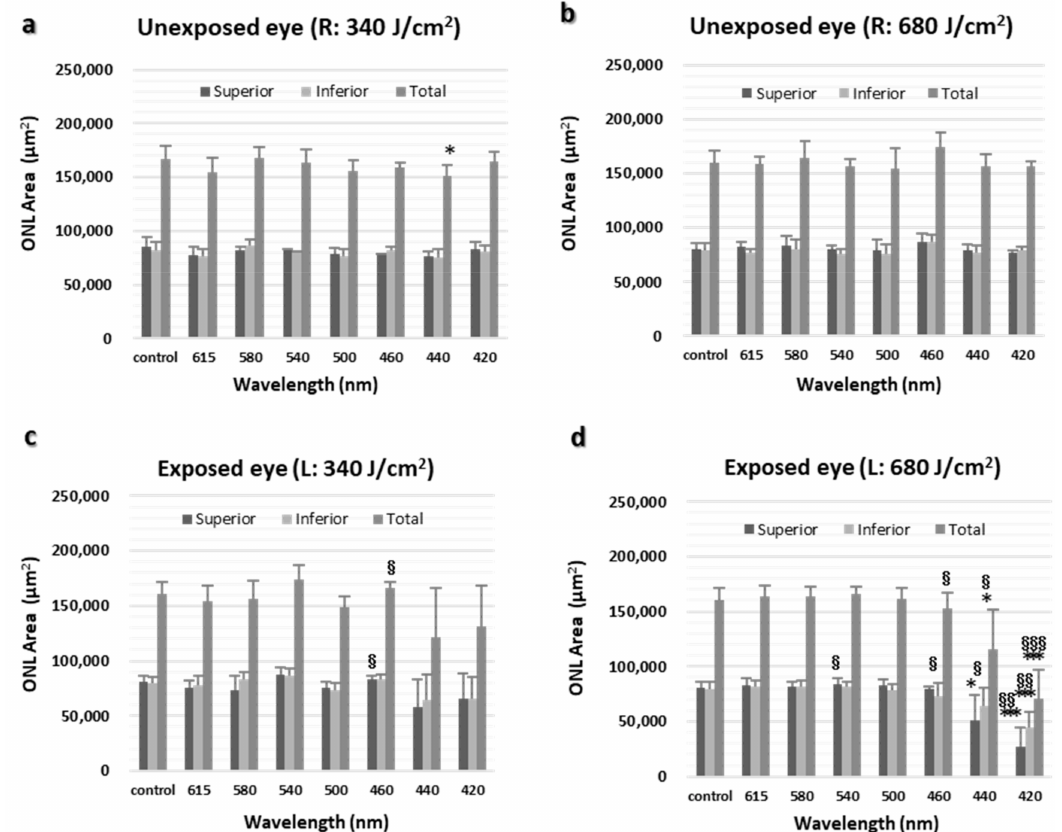
Figure 3. ONL area. ( a ) ONL area of normal retina (right eye) and opposite retina exposed to 340 J/cm 2 (right eye). ( b ) ONL area of normal retina (right eye) and opposite retina exposed to 680 J/cm 2 (right eye). ( c ) ONL area of normal retina (left eye) and retina exposed to 340 J/cm 2 (left eye). ( d ) ONL area of normal retina (left eye) and retina exposed to 680 J/cm 2 (left eye). L, left eye; R, right eye. The data are expressed as mean ± SD ( n = 6 in each group). Both eyes were compared using the paired t -test, and between-group comparisons were performed using the unpaired t -test. * p < 0.05 and *** p < 0.001 vs. normal control eyes and § p < 0.05, §§ p < 0.01, and §§§ p < 0.001 vs. unexposed